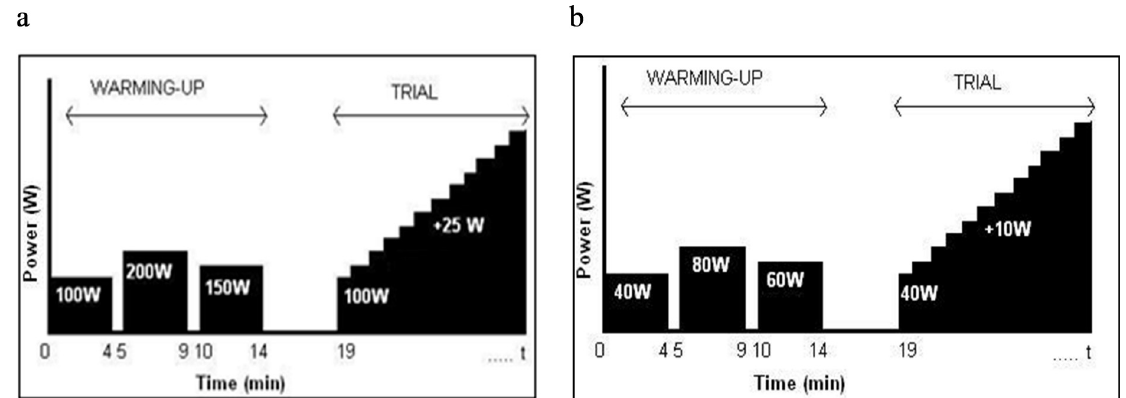
Fig 2. Incremental tests protocol. a. Leg Cycle test protocol and b. Handcycle test protocol.